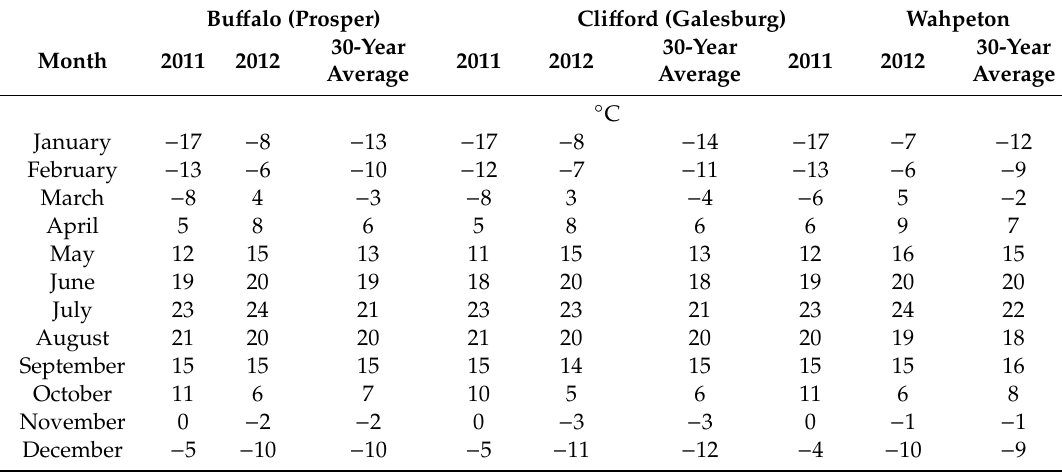
Table 1. Average monthly air temperatures for 2011 and 2012, and normal monthly air temperatures ( ◦ C) at field locations collected from nearest North Dakota Agriculture Weather Network (NDAWN) weather station (in